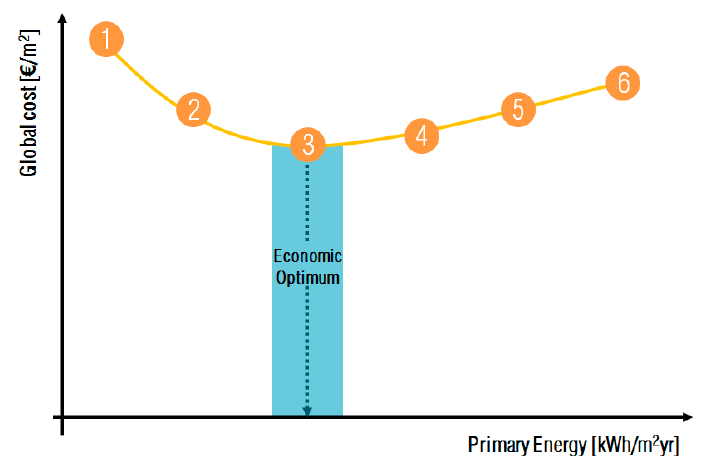
Figure 2. Economic optimum and cost curve of different packages adapted from [22].